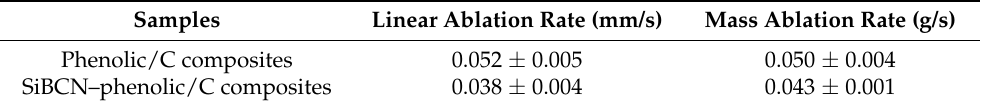
Table 3. Ablation properties of phenolic/C composites and SiBCN–phenolic/C composites.